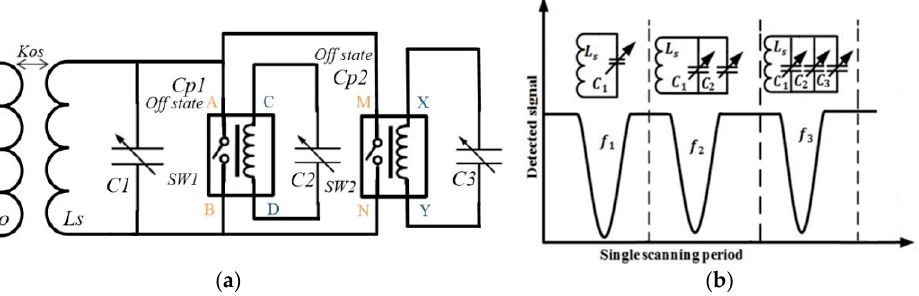
Figure 3. Theoretical model demonstration ( a ) LC triple parameters monitoring system integrated with two relay switches. ( b ) Representation of working principle.